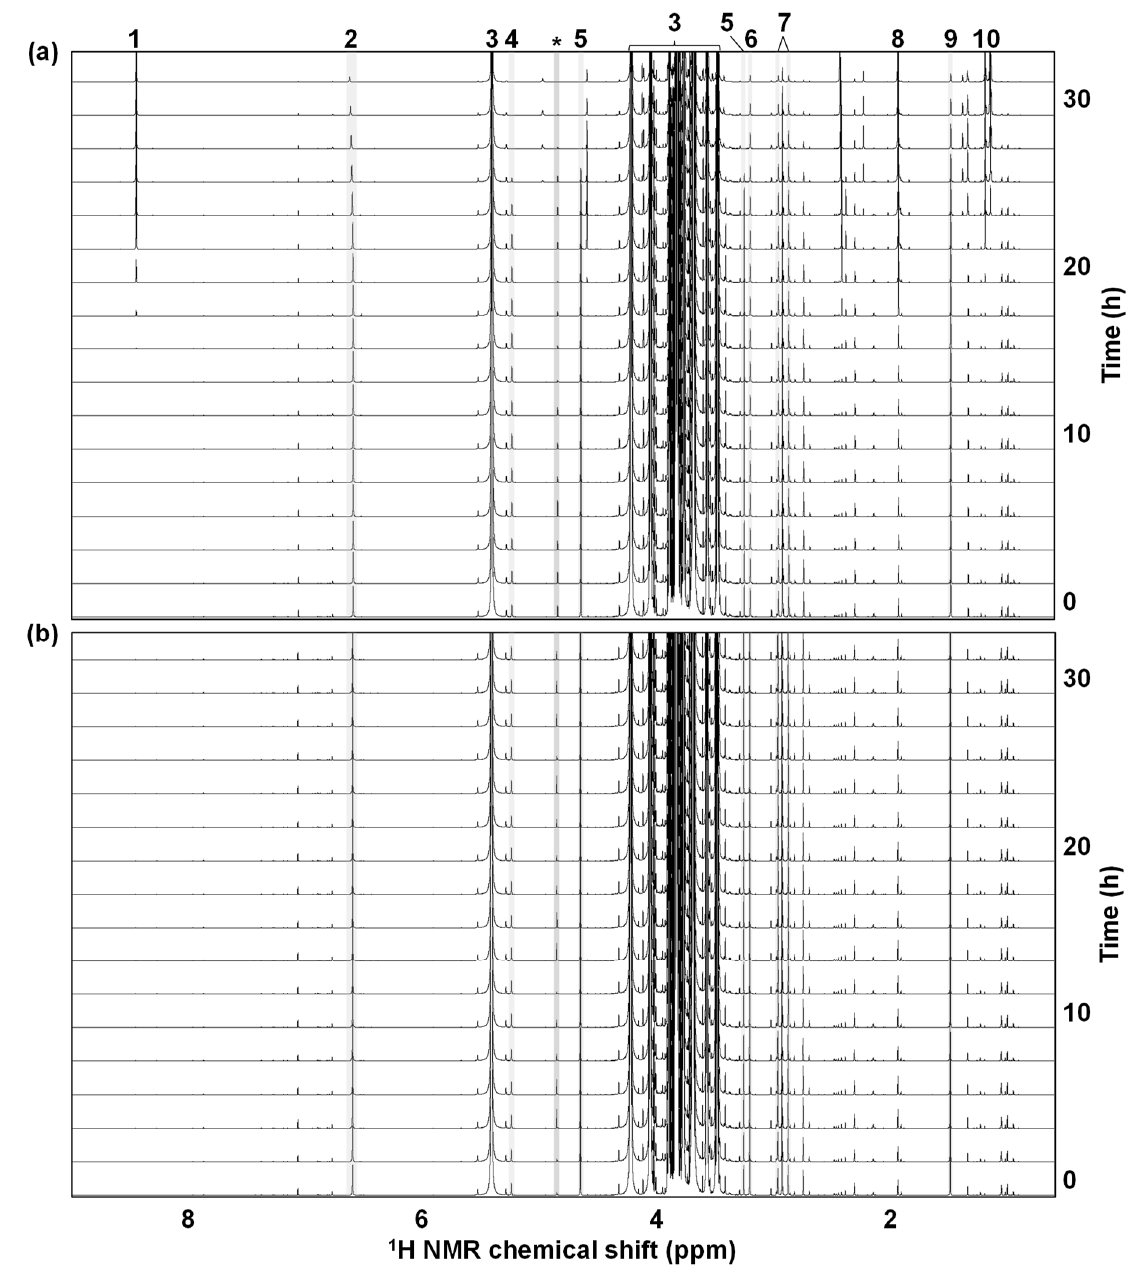
Figure 3. Time-course changes of metabolite compositions in sugarcane juice during the NMR meas- urements. The samples were processed with no thermal treatment ( a ) or thermal treatment at 95 °C for 10 min ( b ). 1, formic acid; 2, trans -aconitic acid; 3, sucrose; 4, α -glucose; 5, β -glucose; 6, choline; 7, asparagine; 8, acetic acid; 9, alanine; 10, ethanol; *, solvent: water.